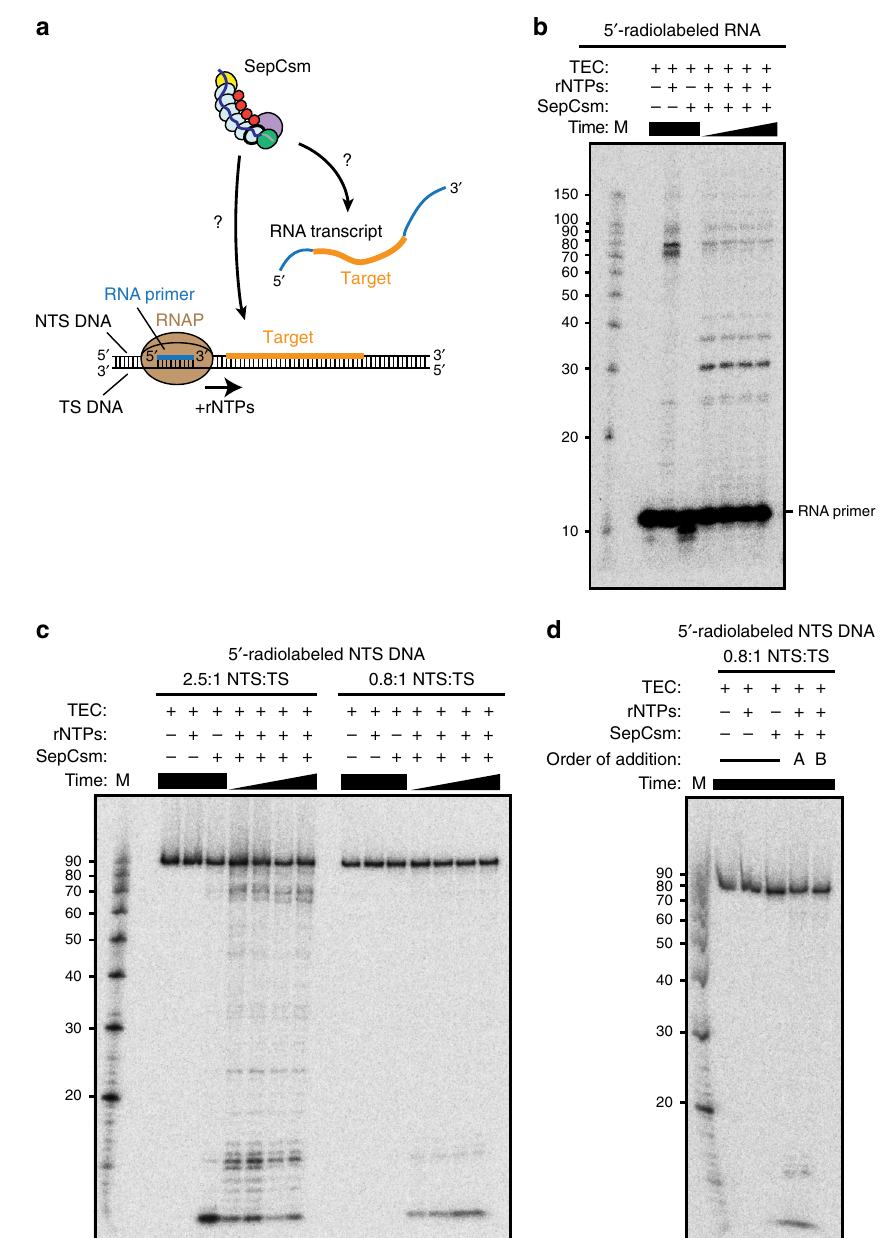
Fig. 5 Testing co-transcriptional DNA and RNA targeting activities of SepCsm. a Schematic of the TEC used in the co-transcriptional DNA cleavage assay. The TEC was assembled with RNAP, a short RNA primer, nontemplate strand (NTS DNA), and template strand (TS DNA) of DNA. Ribonucleotides (rNTPs) were added to initiate transcription across the DNA and produce an RNA transcript. The NTS DNA and corresponding RNA transcript contains a target sequence (highlighted in orange) that is complementary to the crRNA guide sequence in SepCsm. b Co-transcriptional cleavage of 5´-radiolabeled RNA by SepCsm, analyzed by denaturing PAGE. Transcription was fi rst initiated across the target sequence in the DNA by addition of rNTPs, followed by addition of SepCsm after 10 min. For reactions with both SepCsm and rNTPs added, samples were taken at 30, 60, 90, and 120 min after SepCsm addition. For all other reactions, samples were taken at 120 min. An RNA Decade ™ marker (M) is loaded in the leftmost lane. c Co-transcriptional cleavage of 5´- radiolabeled NTS DNA by SepCsm, analyzed by denaturing PAGE. The assay was performed as in ( b ). The molar ratio of NTS to TS used in TEC assembly is given above the gel. A ssDNA marker (M) was loaded in the leftmost lane for comparison. d Comparison of co-transcriptional DNA cleavage by SepCsm when it is added before or after transcription is initiated. SepCsm was added either 10 min after (A) or 10 min before (B) rNTPs were added to initiate transcription of TECs containing a limiting amount of nontemplate strand DNA. After 30 min, reactions were halted and samples were analyzed as in c . All other reactions were incubated for the total length of the assay (40 min) before analysis. A ssDNA marker (M) was loaded in the leftmost lane for comparison. Uncropped gel images for ( b – d ) are available online in the Source Data fi